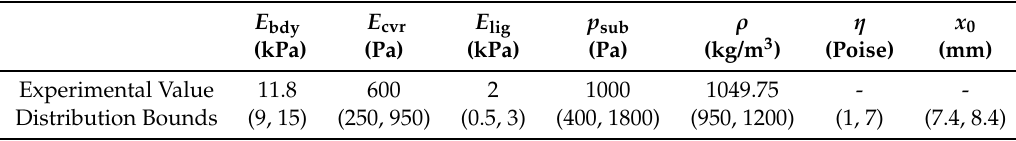
Table 2. List of the the experimental values and prior distributions used for the estimated parameters. The distribution bounds are the bounds of the employed uniform prior distribution (lower bound, upper